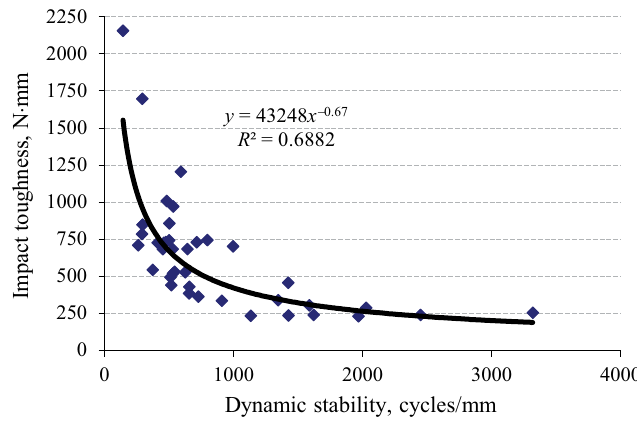
Dynamic stability, Figure 11. Relationship between impact toughness and dynamic stability for mastic asphalt